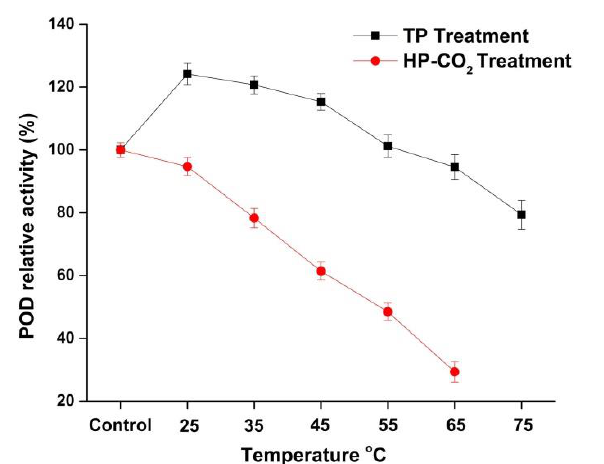
Figure 3. Relative activity of peroxidase (POD) in apple juice under thermal processing (TP) (25–75 and high pressure carbon dioxide (HP-CO 2 ) (25–65 ◦ C for 20 MPa) treatment for 20 min. Data presented °C) and high pressure carbon dioxide (HP-CO 2 ) (25–65 °C for 20 MPa) treatment for 20 min. Data as the mean ± SD (standard presented as the mean ± SD (standard deviation).